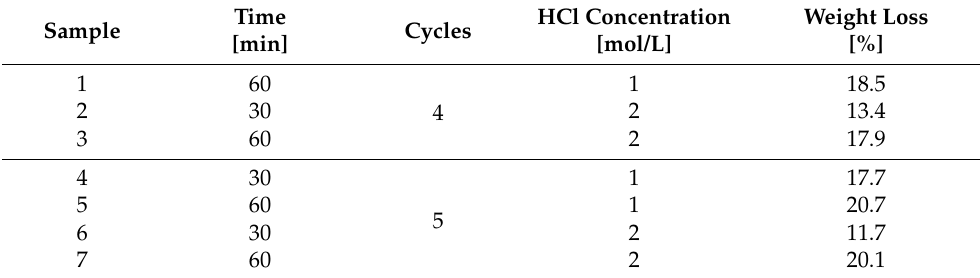
Table 2. Results of removal of mineral